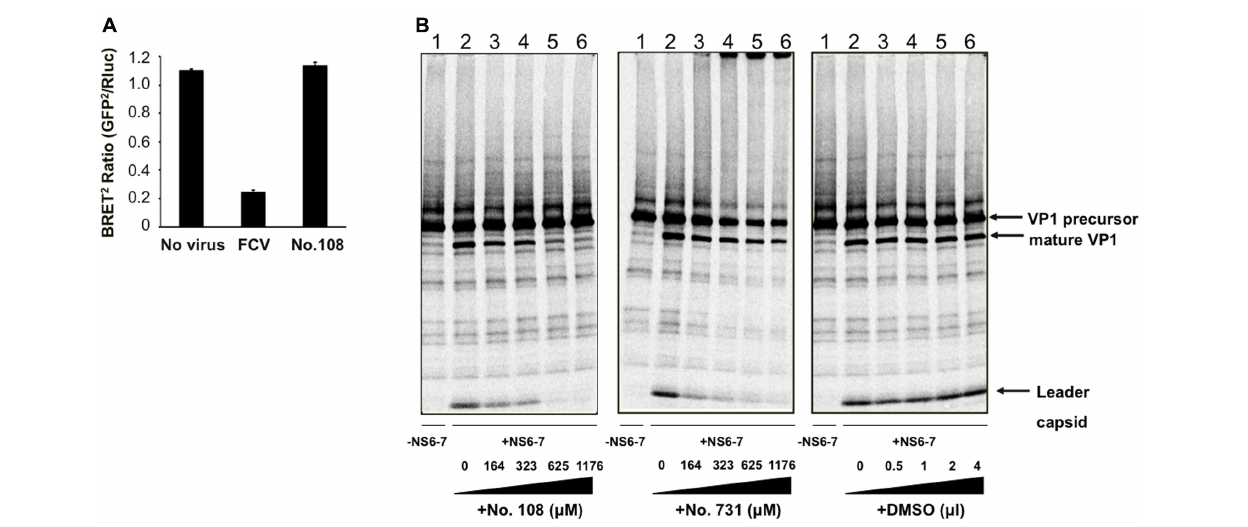
FIGURE 3 | Evaluation of anti-FCV protease activity of the candidate molecules. (A) BRET 2 -based FCV protease activity assay (Oka et al., 2011). BRET 2 -FCV-Cut- expressing CRFK cells (Oka et al., 2011) were infected with the FCV F4 strain at an MOI of 10, and incubated for 6 h. BRET 2 signals in FCV non-infected cells, FCV-infected cells, and FCV-infected cells in the presence of the compound No. 108 (45 µ M) were measured. The BRET 2 ratio was defined as the intensity of GFP 2 emission at 515 nm divided by that of Rluc at 410 nm. Error bars represent the standard error of the mean ( n = 2). (B) In vitro proteolysis assay. [ 35 S]-labeled, His-tagged VP1 precursor protein of the FCV F4 strain and non-radiolabeled His-tagged NS6-7 protein containing protease of F4 strain (Oka et al., 2007) were separately expressed using in vitro transcription-translation system (Oka et al., 2009). Translational products were then purified with MagZ Protein Purification System (Promega) and mixed. To examine the effects of candidate compounds, 0–4 µ l of No. 108 (left panel), No. 731 (middle panel), or DMSO (right panel) was added into 30 µ l of the substrate-protease mixture, and the mixtures were incubated at 30 ◦ C for 20 h and separated by SDS-polyacrylamide gel electrophoresis (Oka et al.,